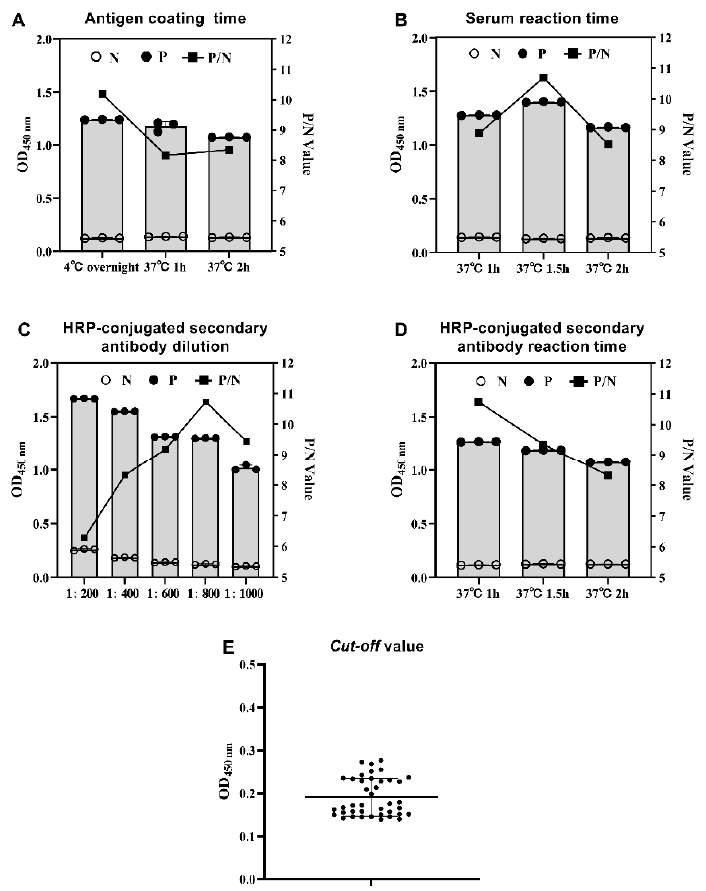
Figure 3. Optimization of GAstV-1-ELISA reaction conditions. ( A ) Optimization of virus coating conditions. ELISA plates with 1.2 µ g/well coating virus were incubated at 4 ◦ C overnight, 37 ◦ C for 1 h, and 37 ◦ C for 2 h. ( B ) Optimization of reaction time of sera. The sera with dilutions of 1:400 was reacted at 37 ◦ C for 1 h, 1.5 h, and 2 h. ( C ) Optimization of HRP-conjugated secondary antibody dilution. The dilution of the HRP-conjugated secondary antibody was 1:200, 1:400, 1:600, 1:800, and 1:1000. ( D ) Optimization of HRP-conjugated secondary antibody reaction time. The HRP-conjugated secondary antibody was reacted at 37 ◦ C for 1 h, 1.5 h, and 2 h. ( E ) The determination of GAstV-1-ELISA cut-off value. Forty negative sera were used to calculate the cut-off value of GAstV-1-ELISA.